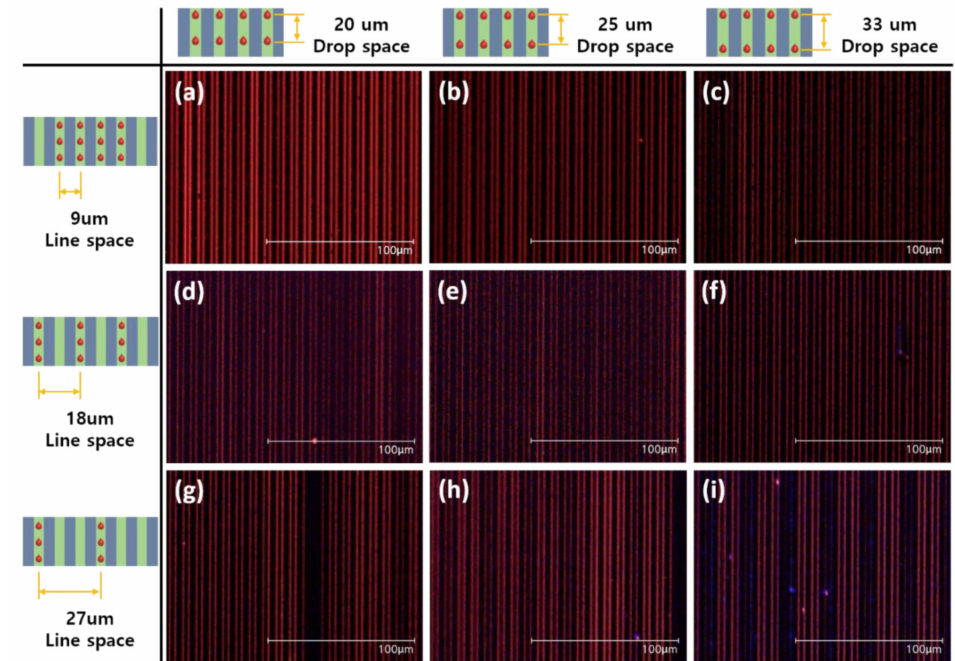
Figure 3. OM images of inkjet-printed onto the microchannel on the donor substrate with UV exposure according to the drop and line space. Inkjet-printed with ( a – c ) 9 µ m, ( d – f ) 18 µ m, and ( g – i ) 27 µ m for line space, and ( a , d , g ) 20 µ m, ( b , e , h ) 25 µ m, ( c , f , i ) and 33 µ m for drop